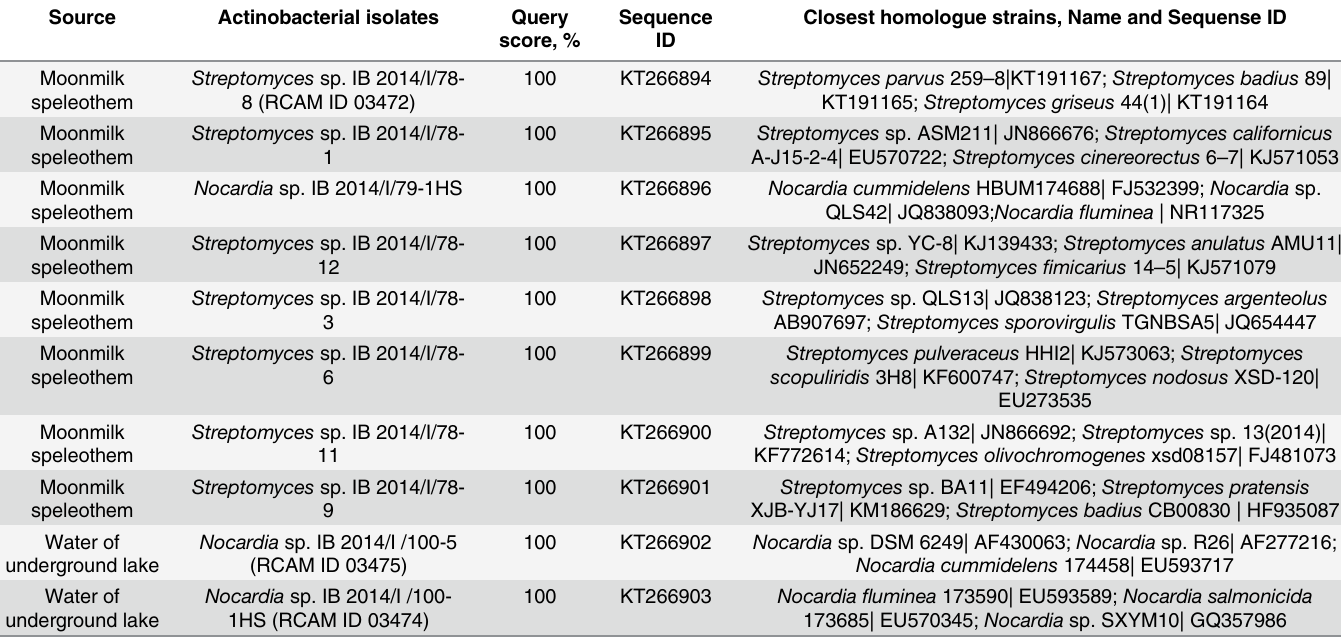
Table 1. Actinobactreria strains isolated from water from an underground lake and moonmilk speleothem from the Bolshaya oreshnaya